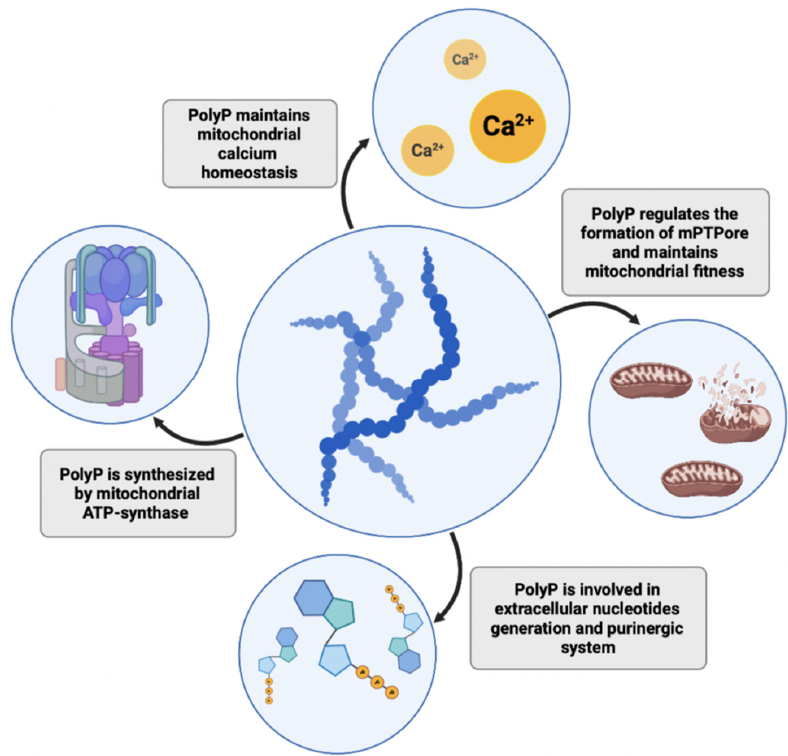
Figure 2. PolyP plays several roles in mitochondria and cell bioenergetics. The polymer is synthe- sized in mitochondria by ATP synthase, where it maintains calcium homeostasis and protects against the formation of calcium phosphate precipitates. It also regulates the processes of mitochondrial permeability transition and formation of mitochondrial permeability pores (mPTPores), thus maintaining mitochondrial fitness. PolyP is also involved in the purinergic system and the genera ‐ tion of extracellular nucleotides.